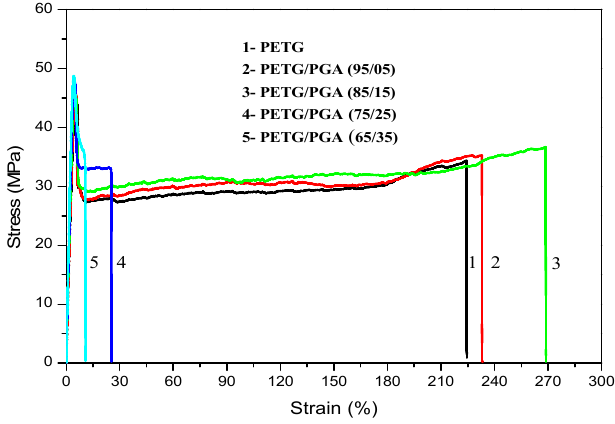
Figure 2. Tensile strain–stress curves of PETG/PGA samples.